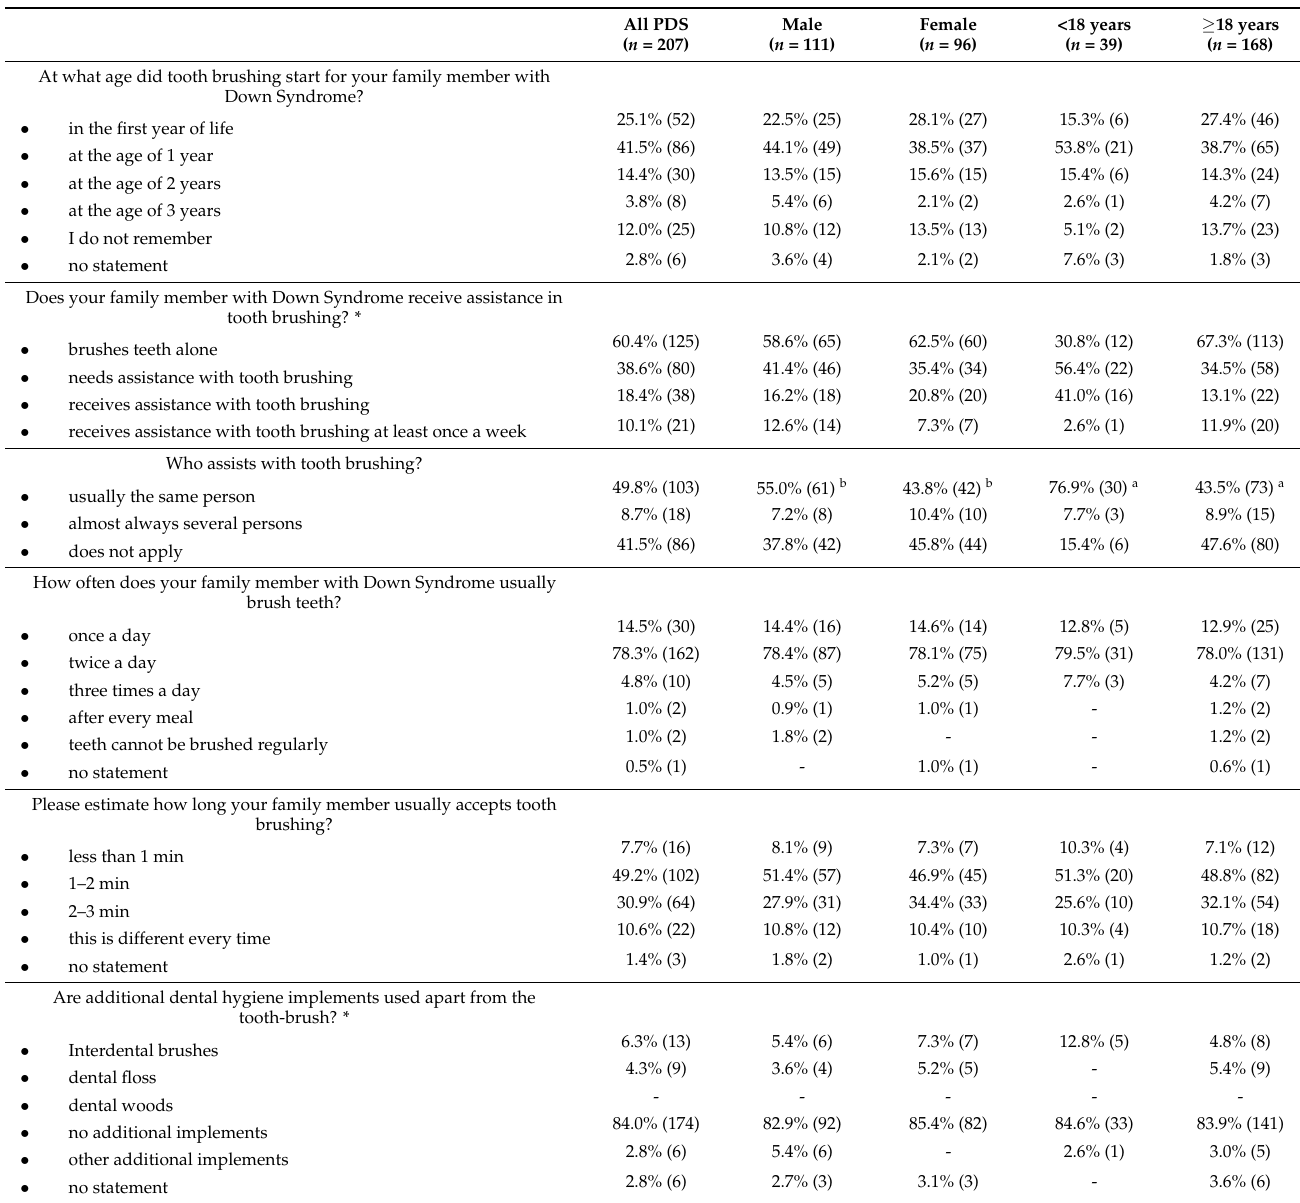
Table 3. Tooth brushing preferences and fluoride use of the People with Down Syndrome (PDS), as reported by the person who completed the